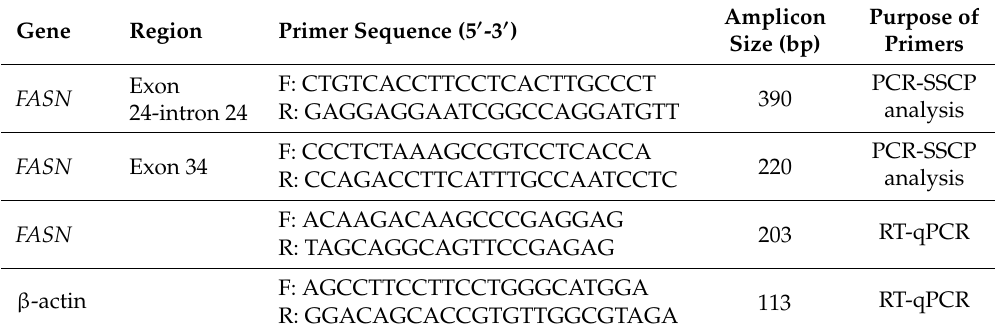
Table 1. Polymerase chain reaction (PCR) primers used in this